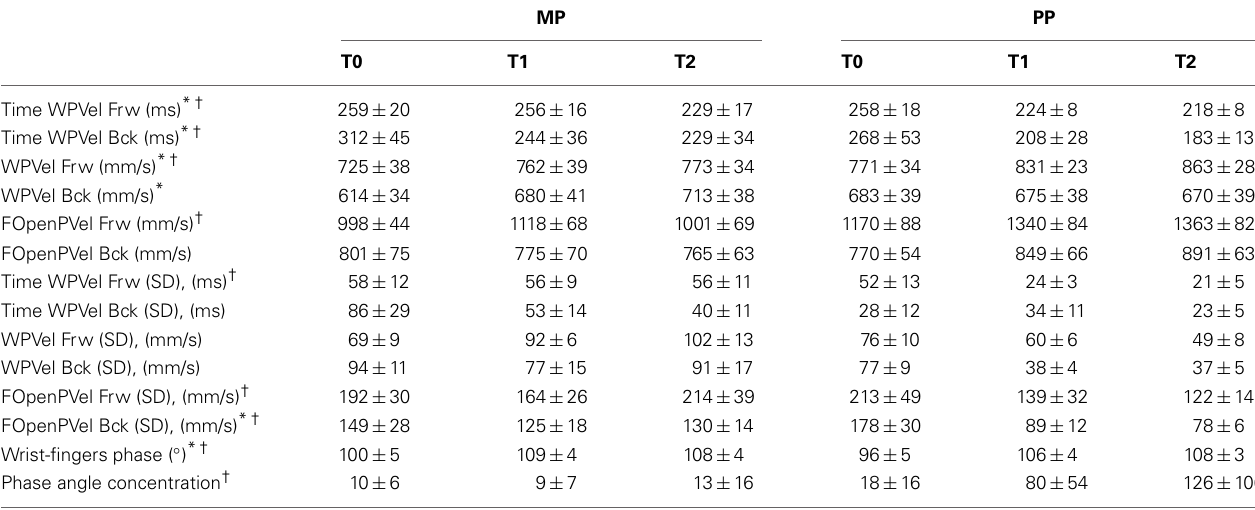
Table 1 | Summary of movement kinematics.